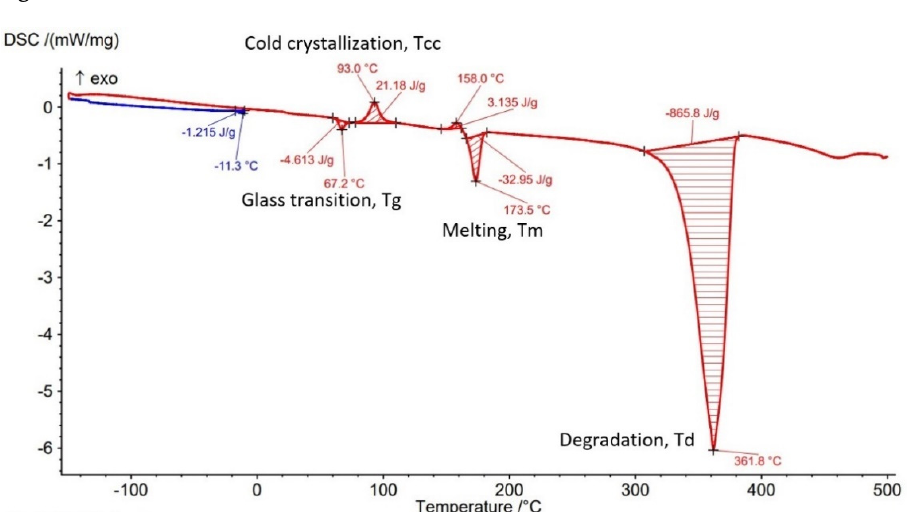
Figure 8. DSC results for sample with 25% infill density.